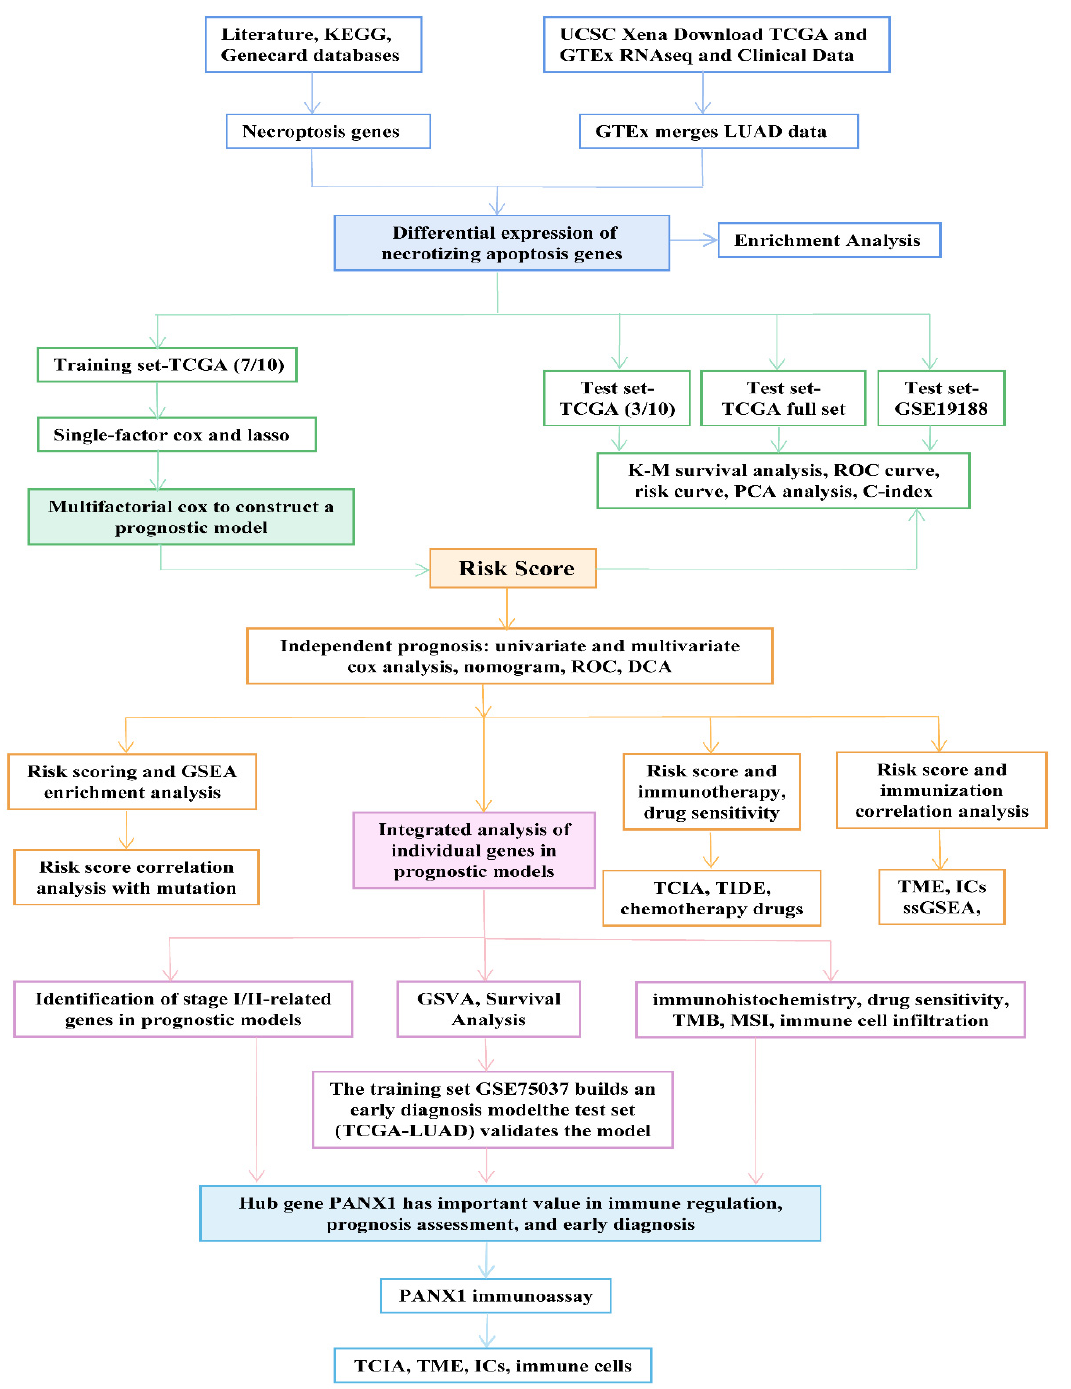
Figure 1. Overview of the analytical process of this study.